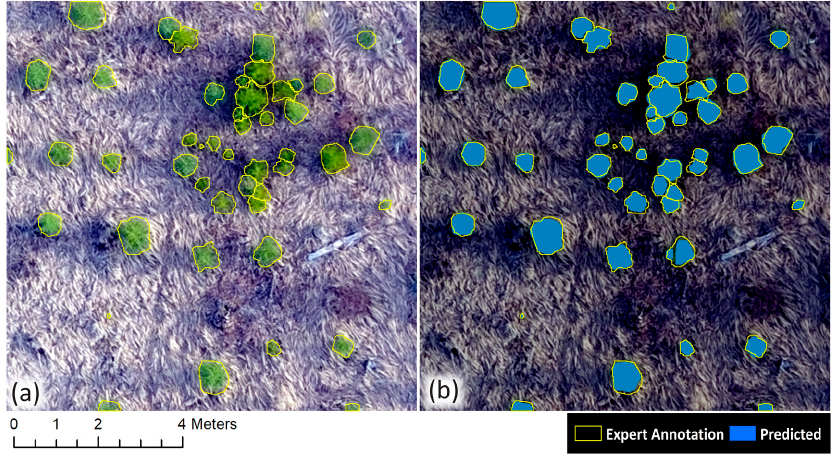
Figure 8. External Validation Tile g (B39). Annotated ground truth ITC are displayed yellow in both panels. The original image is displayed in ( a ). Predicted ITC are displayed in blue ( b ).